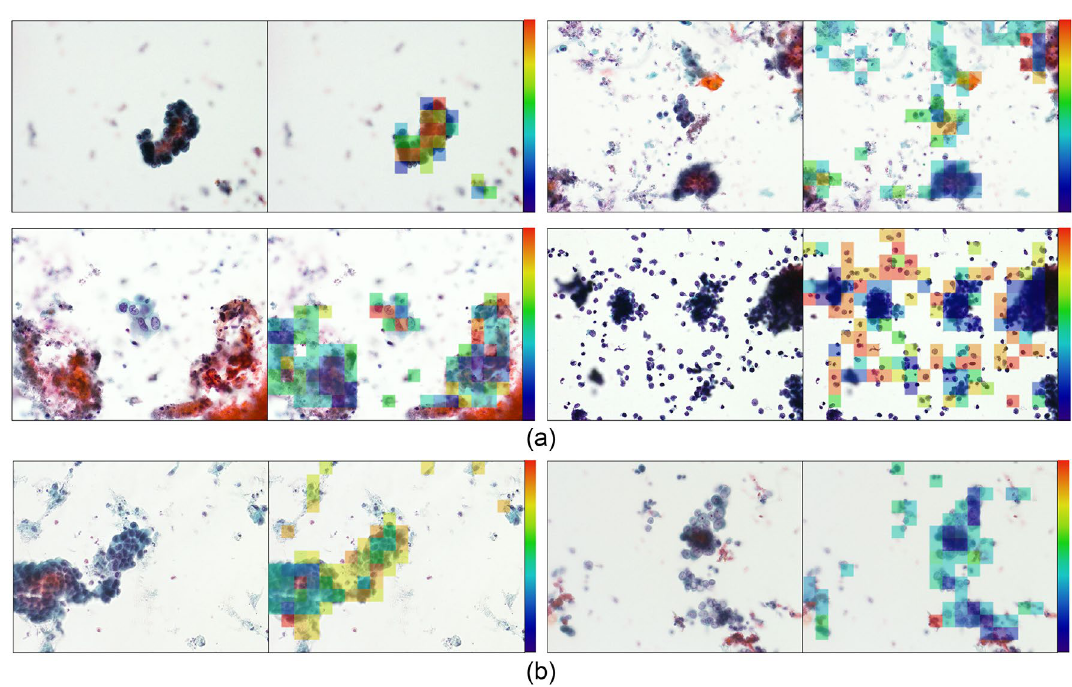
Figure 6. Classification result and attention maps on attention weight of malignant cells. ( a ) Correctly classified malignant cells. ( b ) Mis-classified malignant